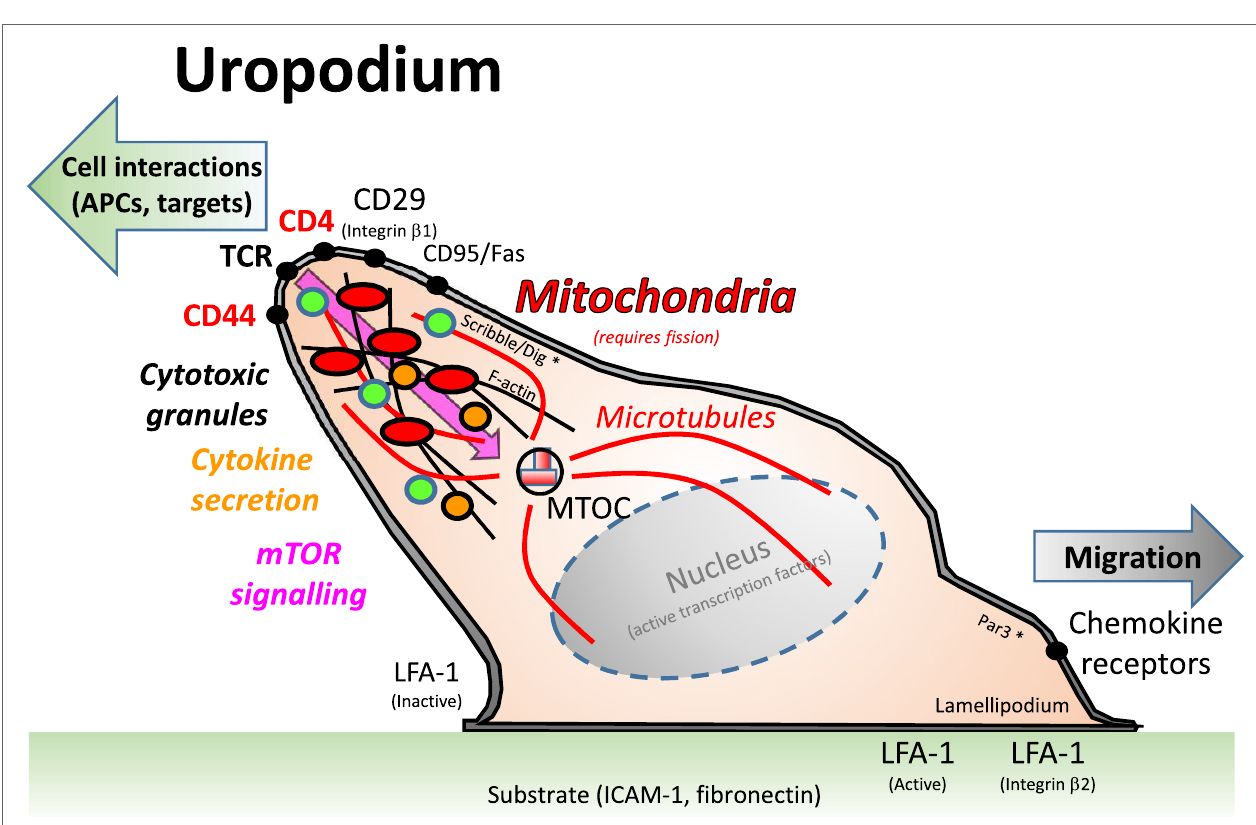
FigUre 7 | A depiction of the uropodium structure in lymphocytes. Adapted from Ref. (46). Uropodia are found at the back of activated lymphocytes that are migrating on a substrate, usually an intracellular matrix containing integrin ligands, such as ICAM-1 or fibronectin, toward a chemokine cue. The uropodium is organized as a large, finger-like projection by the cytoskeleton and microtubules, with the microtubule organizing center (MTOC) at its base. The polarization of the cell is maintained by the Scribble/Dig and Par3 complex, which are the same components that have been claimed to be needed for asymmetric cell divisions (8). It is thought that the uropodium is responsible for the interaction of T cells with other cells, such as antigen-presenting cells and targets of cytotoxicity, and, therefore, expresses high levels of TCR, CD4/8, and relevant adhesion molecules (CD44, CD29). The cytotoxic granules of effector T cells are also present within the uropodium, and cytokines are secreted from them. Mitochondria, and many other organelles are also concentrated within the uropodium, which contains the bulk of the cell cytoplasm.